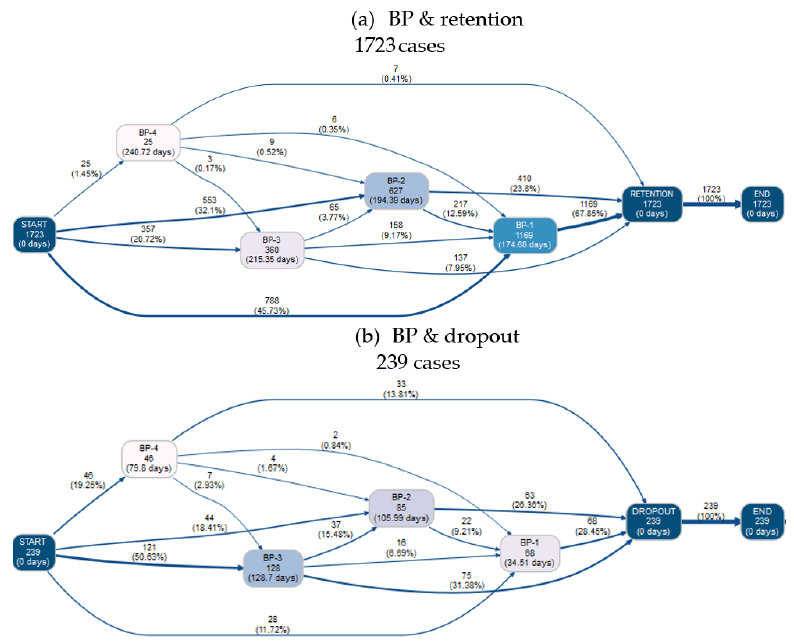
Figure 8. Educational trajectories, according to the BPPM-S model. ( a ) Shows only students who had a backpack and emptied it. ( b ) Shows only students who had a backpack, were not able to empty it and finally dropped out. The darker color of the nodes represents a higher percentage of students who went through a state. The thickness of the arrows represents the percentage of students who had transitions between both states. All values are percentages in relation to the total number of students included in each model.